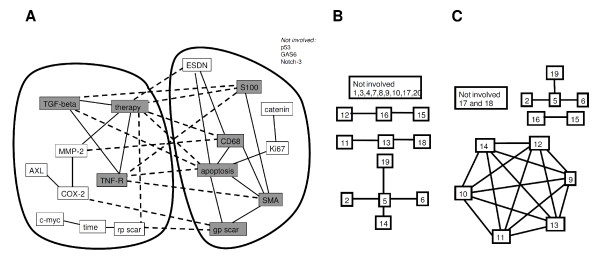
Correlation networks and their analysis in a fictive model system. 2A: Depiction of the collaborative network in the cell infiltrate using significant Spearman's correlation coefficients (p < 0.05). Highly connected proteins with more than 3 significant correlations are marked in grey color; solid lines mark positive correlation coefficient, dotted line negative correlation coefficient. The analyzed tissue proteins include TGF-beta, MMP-2, TNF-R2, COX-2, AXL, c-myc, Ki67, beta-Catenin, ESDN, p53, Gas6, Notch 3, CD68, apoptosis -TUNEL, SMA, collagen type I - red pixel and type III - green pixel. Three therapy groups were compared; ethanol-controls, low dose GC and high dose GC. Figure 2B: Depiction of significant Spearman's correlations within a database of 20 variables, each consisting of 30 random data sets. Figure 2C: Depiction of significant Spearman's correlations within a fictive random database of 20 variables after introduction of a cluster, which included the variables 9 to 14 with equal numerical values, and which led to correlation coefficients of r = 1 between these variables.